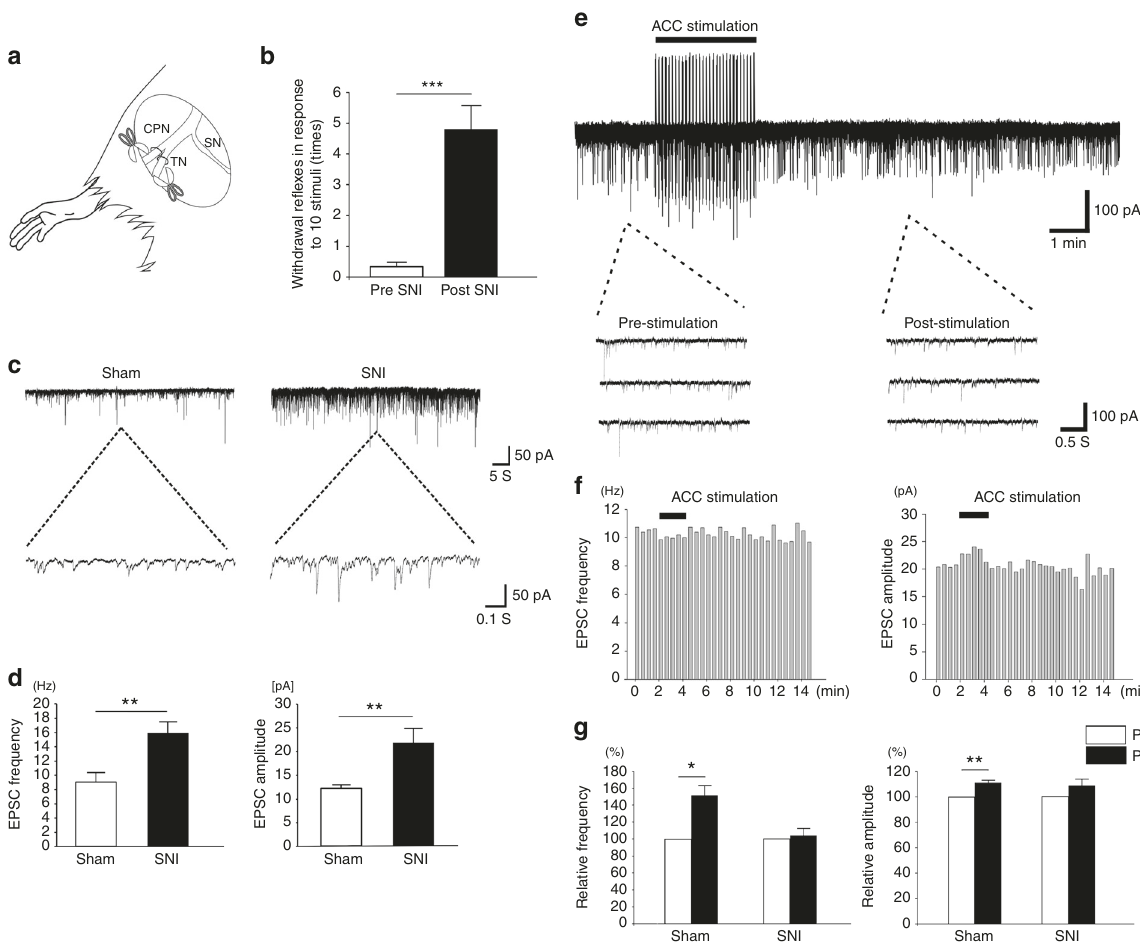
Fig. 2 Potentiated sEPSCs of SDH neurons and the occlusion of ACC-induced facilitation in rats with neuropathic pain. a A schematic diagram showing the SNI model. The tibial nerve (TN) and common peroneal nerve (CPN) were cut and ligated but leaving the sural nerve (SN) intact. b A signi fi cant mechanical allodynia was observed in rats 7 days after SNI surgery (pre SNI, 0.36 ± 0.25 times, post SNI, 4.82 ± 0.78 times, n = 11, *** p < 0.001, unpaired t - test). c Recording samples showing the frequency and amplitude of the sEPSCs of spinal SDH neurons in SNI rats were signi fi cantly potentiated than those in sham operated rats. d Summarized results from 20 SDH neurons in sham and SNI group, respectively. **frequency: p = 0.002; amplitude: p = 0.005, unpaired t -test. e One recording sample showing ACC electrical stimulation could not facilitate the sEPSCs of 1 SDH neuron in rats with SNI. f Histogram fi gures showing the frequency and amplitude of the sample sEPSCs in e before and after ACC stimulation. g Summarized results from 8 SDH neurons in sham group and nine neurons in SNI group. *frequency: p = 0.01; amplitude: p = 0.002, paired t